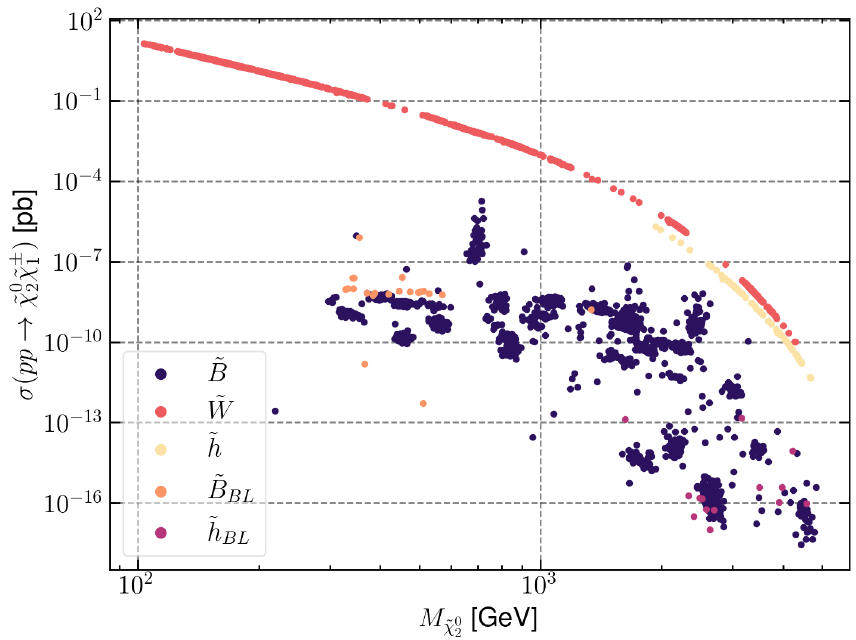
χ 0 χ ± ) production cross section in pb against the mass of the Figure 4: The σ ( pp → (cid:101) 2 (cid:101) 1 second neutralino in GeV. The points are labelled according to the dominant contri- bution of the second neutralino. The shown points pass all constraints of table 2 and satisfy Ω h 2 <